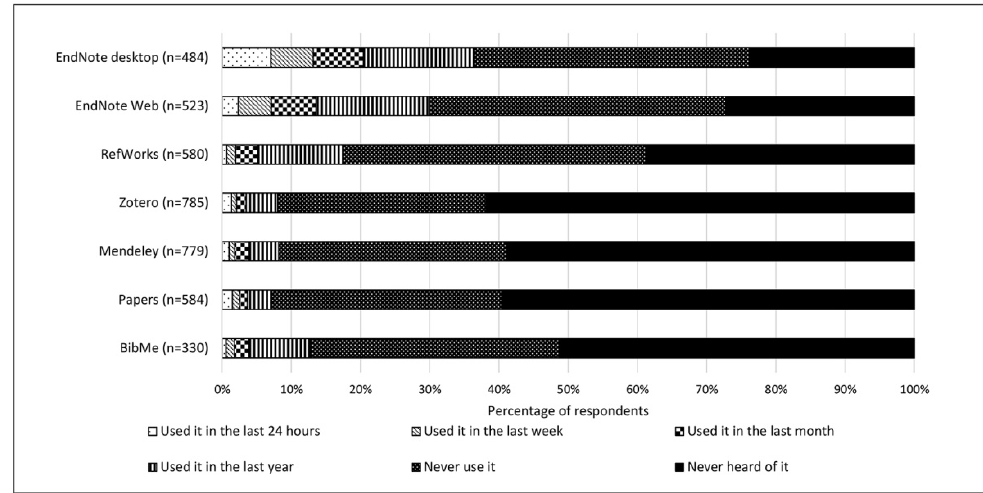
Figure 3 Usage of citation tools